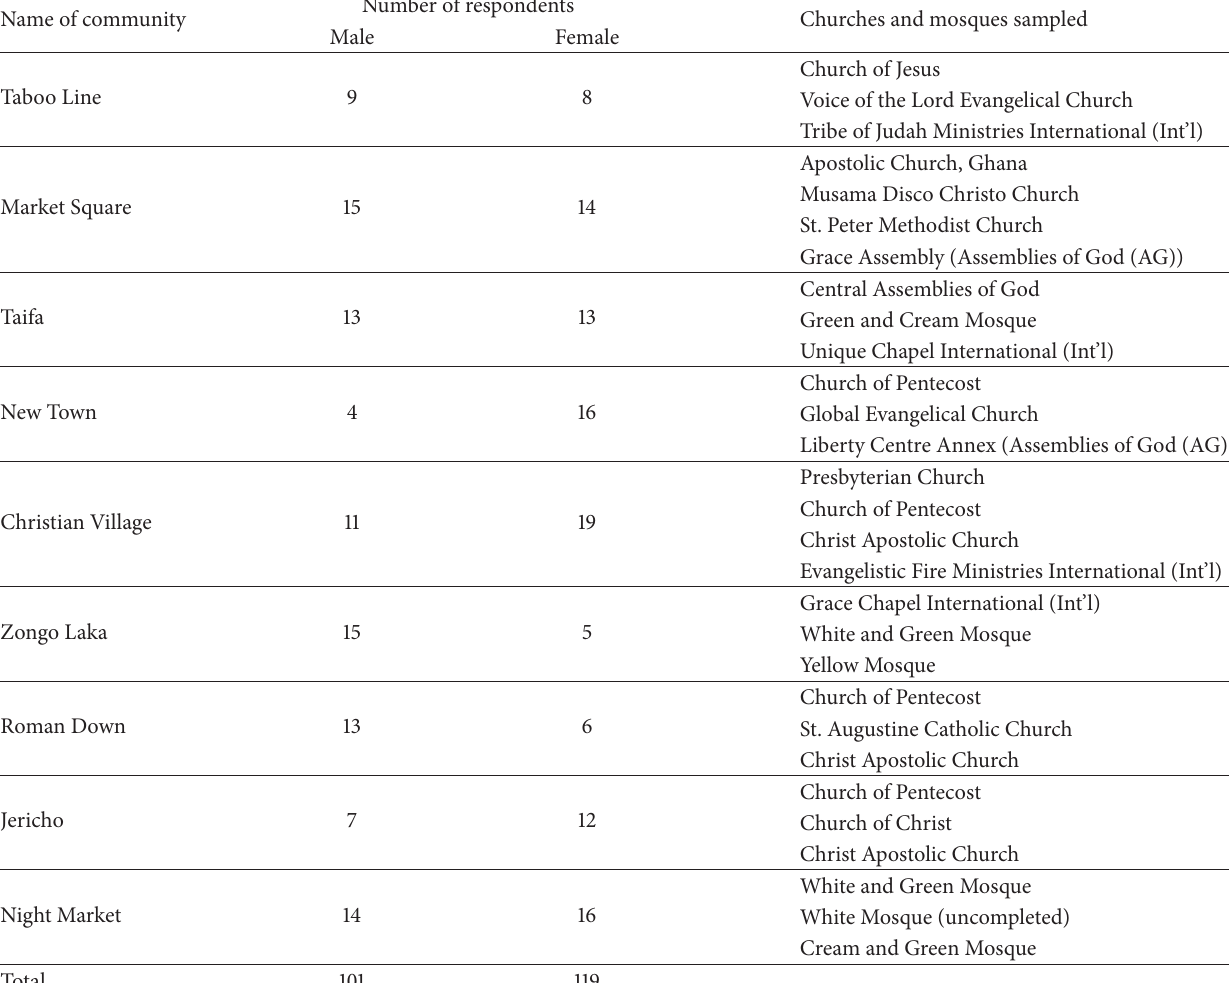
Table 2: Selected communities, churches and mosques, and